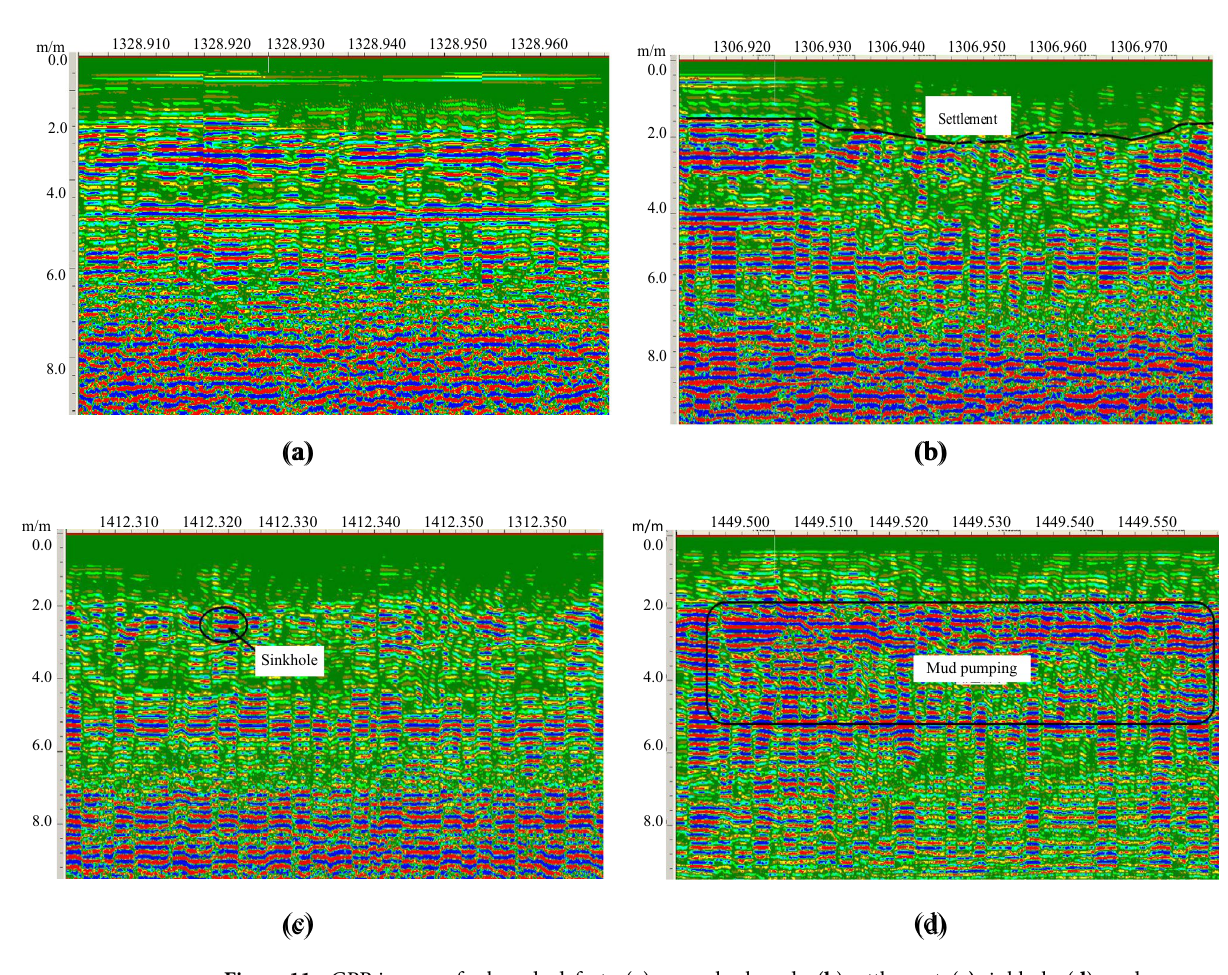
Figure 11. GPR images of subgrade defects. ( a ) normal subgrade, ( b ) settlement, ( c) sinkhole, ( d ) mud